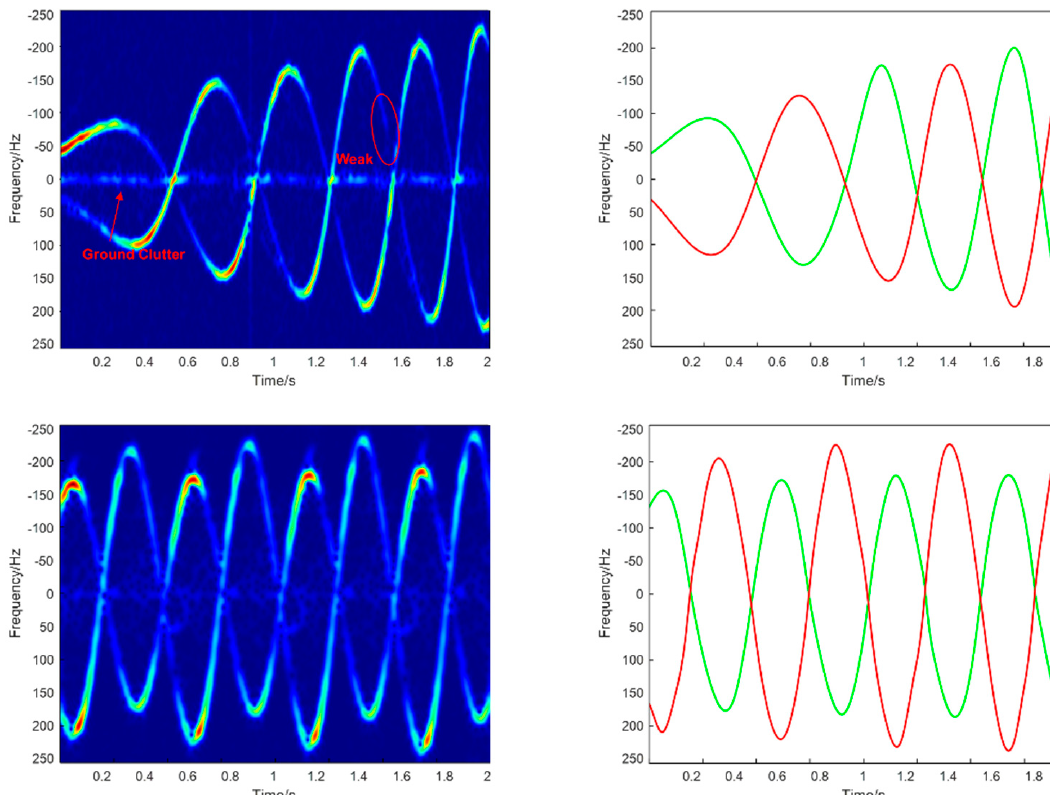
Figure 19. Measured data and results.